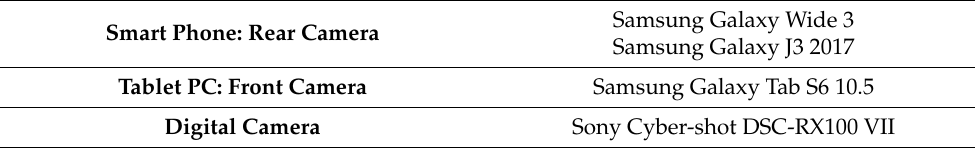
Table 2. Devices used to collect dataset.